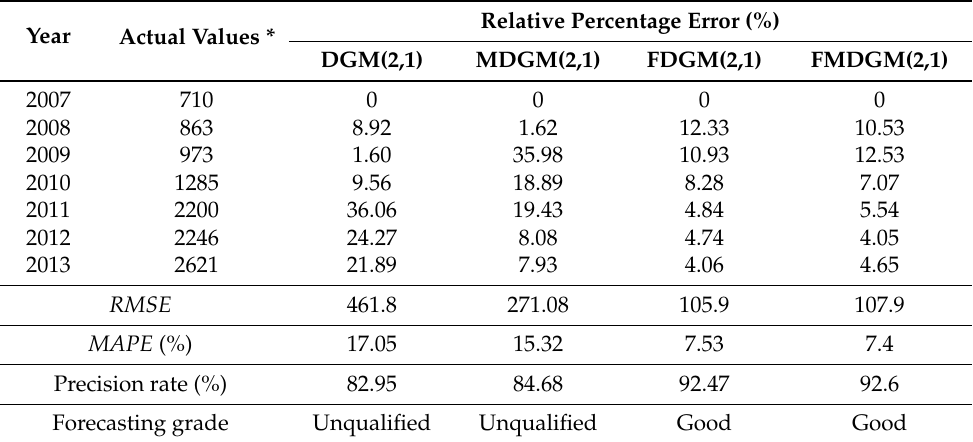
Table 3. Forecasting results for Myanmar’s inbound